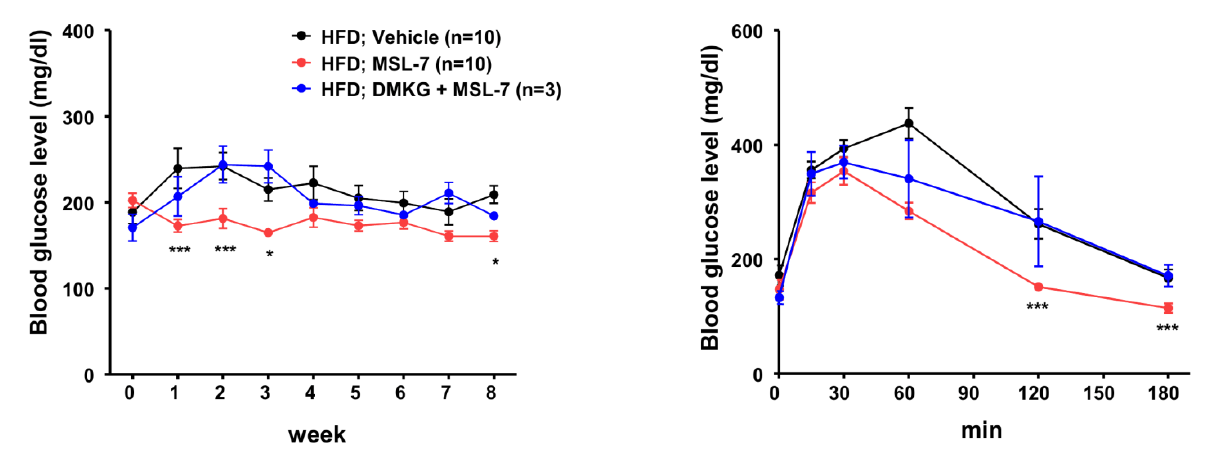
FIGURE 2: Reversal of MSL-7-induced metabolic improvement in HDF-fed mice by an autophagy inhibitor. MSL-7 was administered to mice fed HFD for 8 weeks with or without DMKG, an inhibitor of autophagy. Nonfasting blood glucose level was monitored during admin- istration of MSL-7 and DMKG to HFD-fed mice for 8 weeks (left). Intraperitoneal glucose tolerance test was conducted after 8 weeks of administration